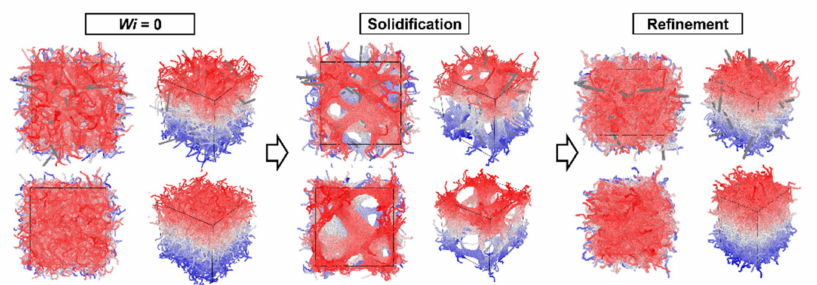
Figure 3. The nanostructure formation process of the PPTA system containing CNTs with Wi of 0 (three-view drawing and stereoscopic view). The direction of CNTs is disordered, and it aggregates with PPTA molecular chains to form microfibers, which become a spatial network structure.